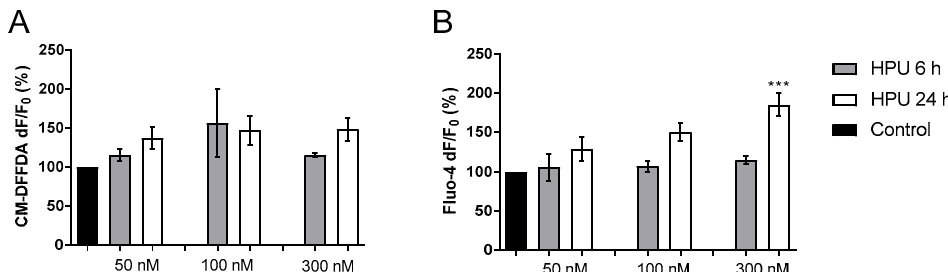
Figure 1. Toxicity of HPU to SH-SY5Y cells. ( A ). Undifferentiated SH-SY5Y cells were incubated with a CM-DFFDA (2 mM) probe for 30 min, 37 ◦ C, in the dark. Cells were treated for 6 h (gray columns) and 24 h (white columns) with 20 mM NaPB (control) or 50, 100 or 300 nM HPU. Fluorescence was measured at λ ex 495 nm/ λ em 527 nm. The results are expressed as a percentage of the control ± SEM and compared by one-way ANOVA followed by the Tukey test. ( B ). For calcium measurement, undifferentiated SH-SY5Y cells were incubated with a Fluo-4AM probe (5 µ M, in 20 mM NaPB) for 45 min, 37 ◦ C, in the dark. The treatment with 50, 100 or 300 nM HPU lasted for 6 h (gray columns) or 24 h (white columns). Controls with 20 mM NaPB (6 and 24 h) were considered 100%. Fluorescence was measured at λ ex 488 nm/ λ em 530 nm. The results were expressed as a percentage of the control ± SEM and compared by one-way ANOVA followed by the Tukey test. *** p < 0.001 vs. control.